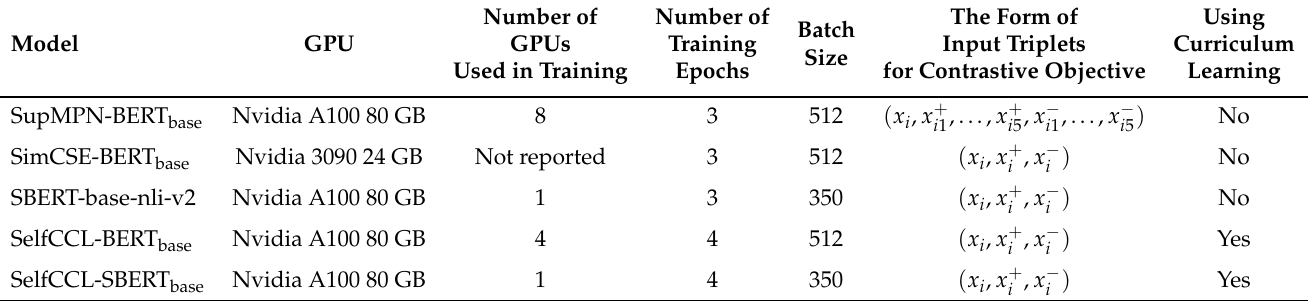
Table 3. The specifications for SBERT-base-nli-v2, SimCSE, SupMPN, and our proposed